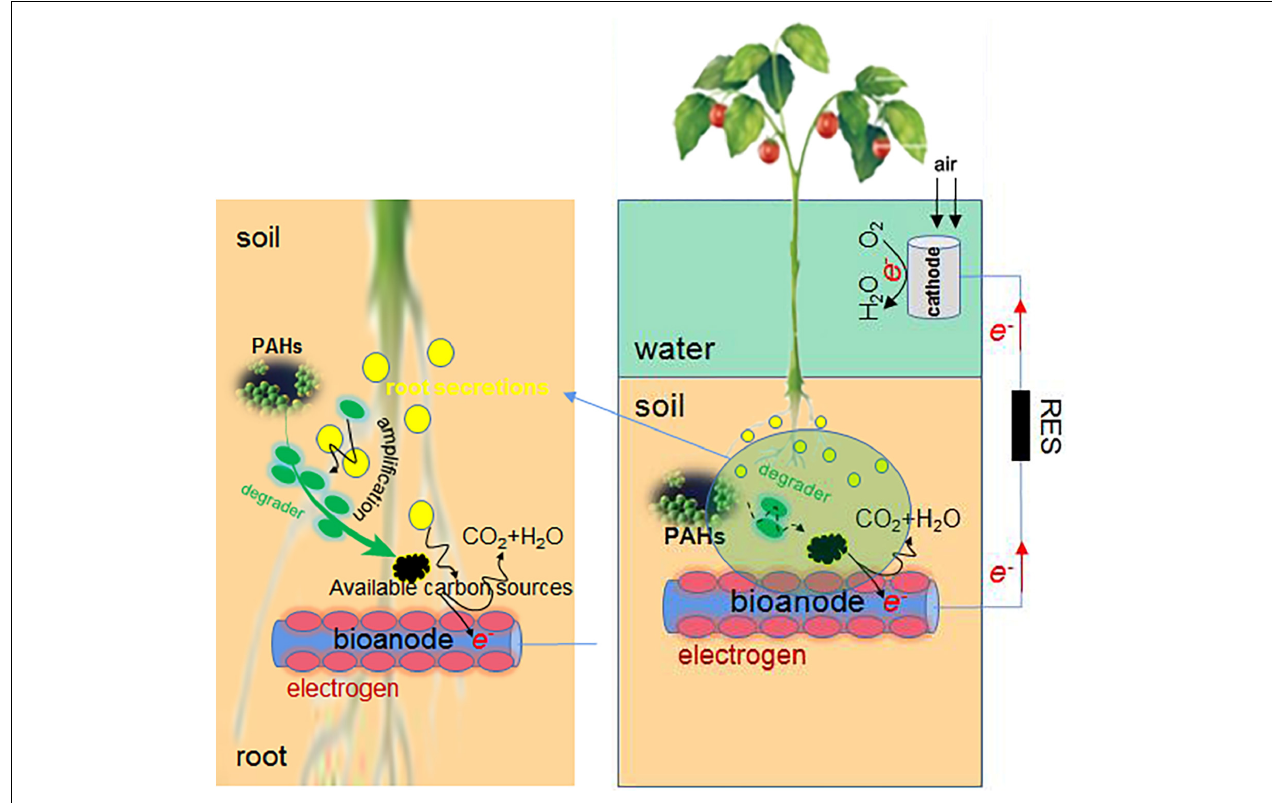
FIGURE 3 | The combined use of phytoremediation and MFC in PAH